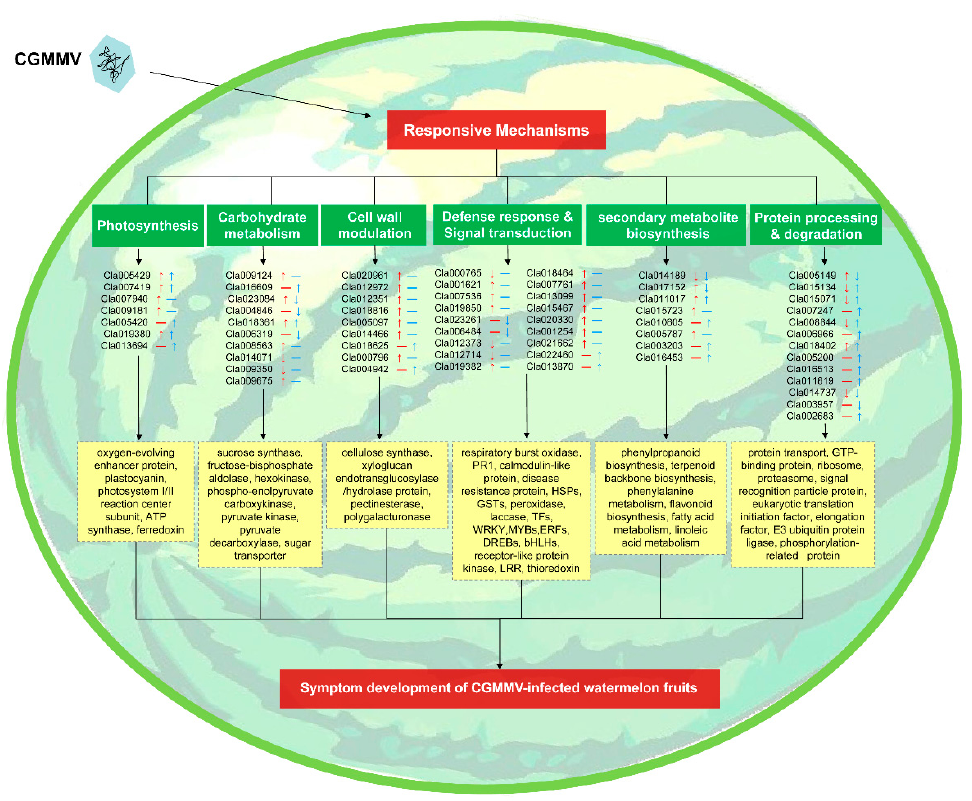
Figure 6. Potential regulation network of a CGMMV-responsive mechanism in watermelon fruits. The arrows and dashes following the gene ID represent the expression patterns of DEGs (red) and DAPs (blue).